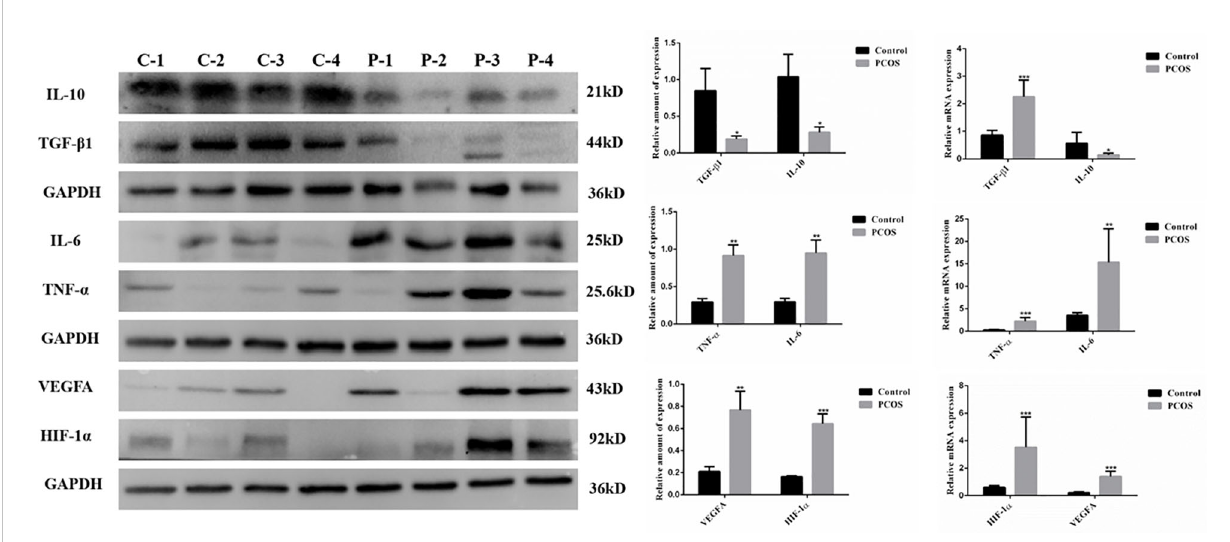
FIGURE 1 Expression offactors associated with in fl ammation and oxidative stress in GCs from PCOS (P) and control (C) group. Compared to the control group, the expression of IL10 and TGF- b 1, which were related to anti-in fl ammatory, was signi fi cantly decreased in GCs from PCOS group (n=25 to 50 in each group). Meanwhile, the expression of pro-in fl ammatory cytokines (TNF a and IL-6) and oxidative stress-related factors (HIF-1 a and VEGFA) was remarkably increased in GCs from PCOS group when compared with control group (n=25 to 46 in each group). (* P <0.05, ** P <0.01, *** P <0.001).